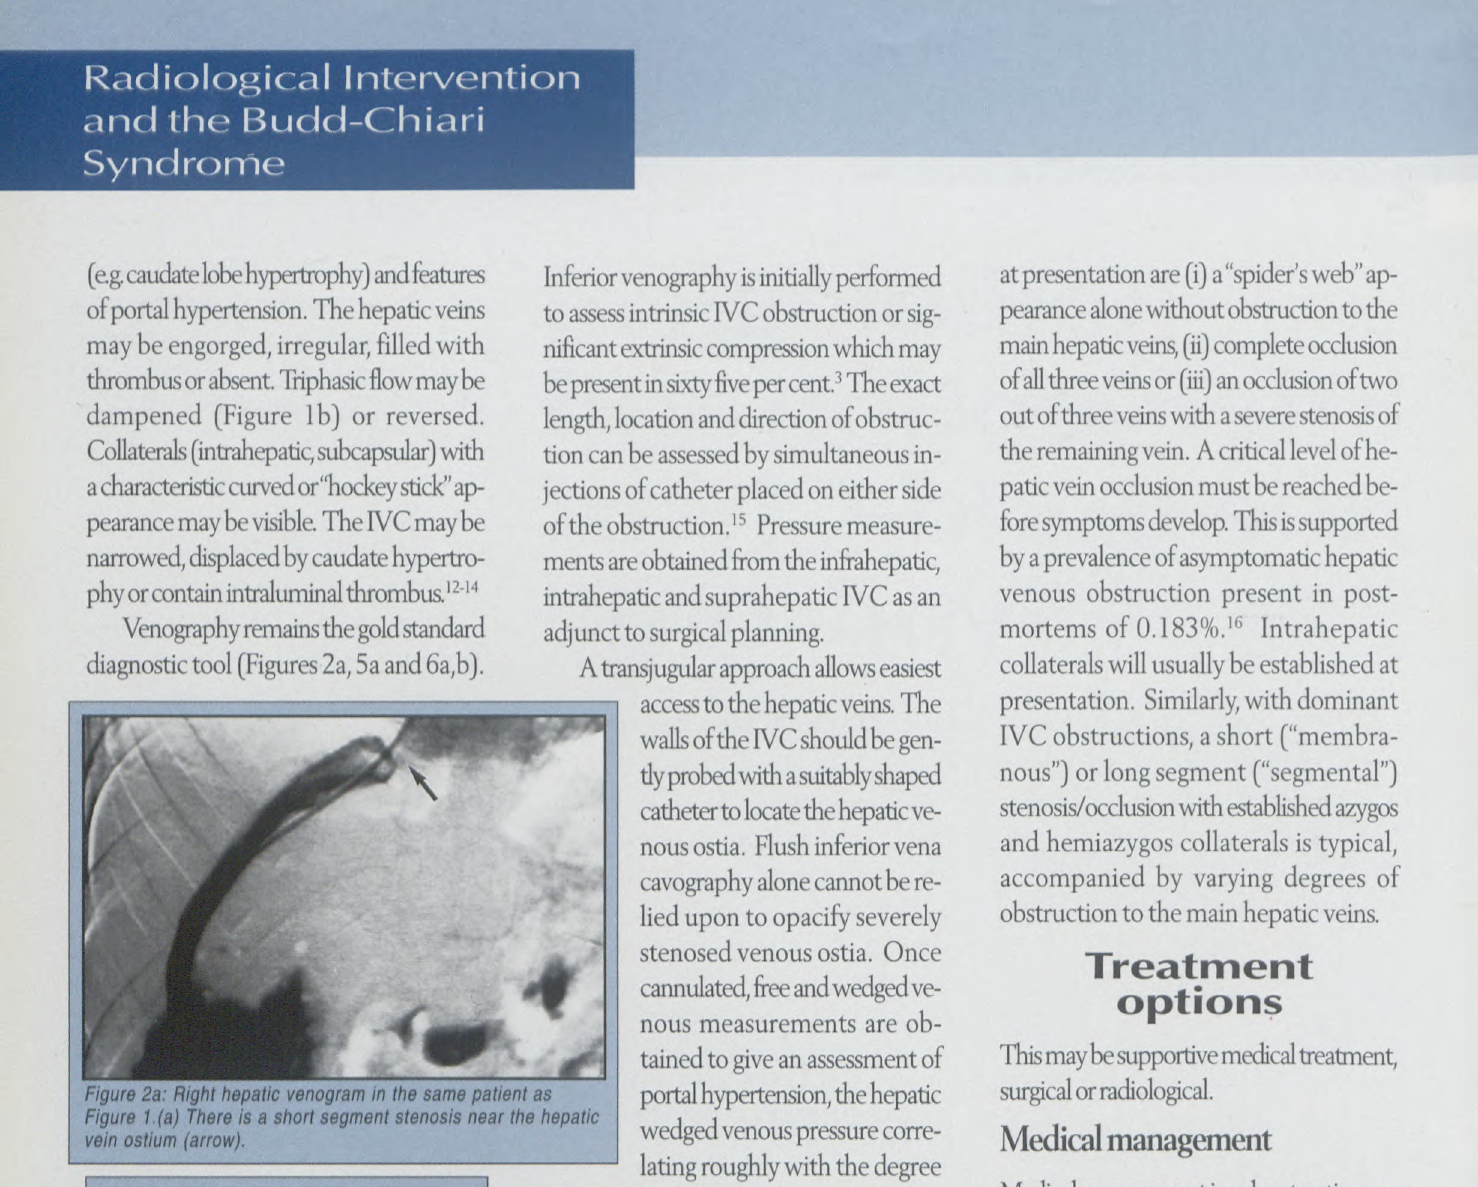
Figure 2a: Right hepatic venogram in the same patient as Figure 1.(a) There is a short segment stenosis near the hepatic vein ostium (arrow).